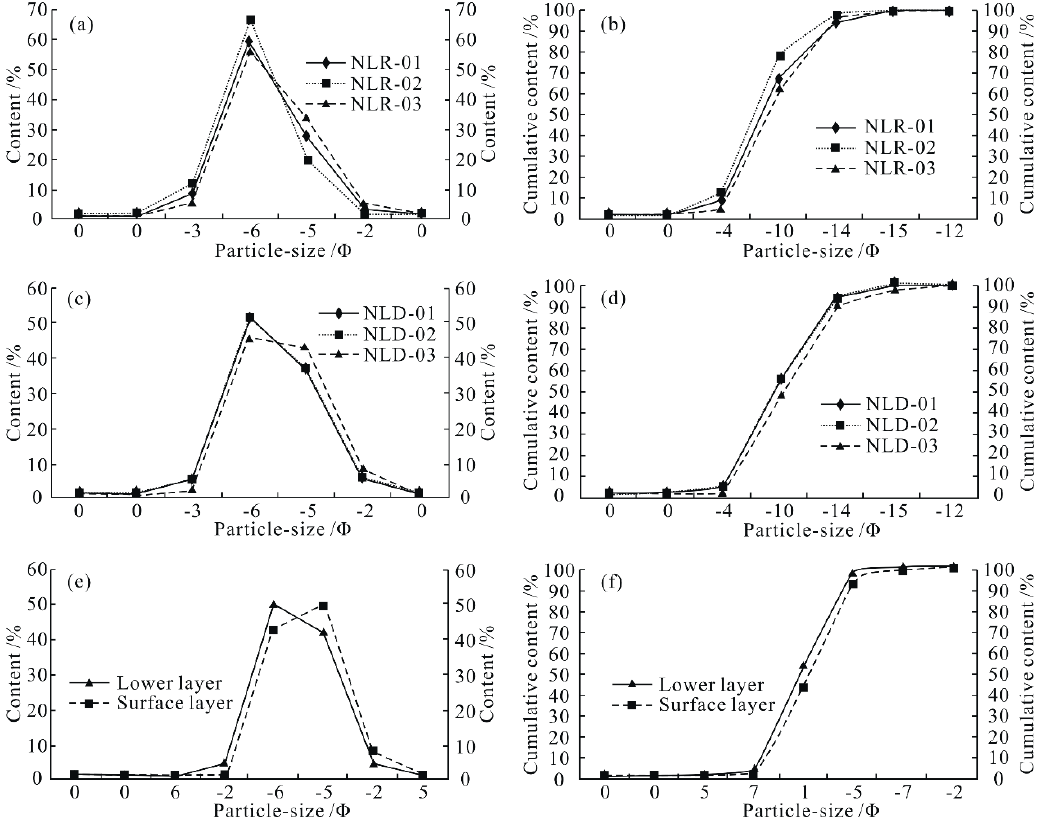
Figure 8. Particle-size frequency distribution and cumulative frequency distribution curves of samples from multi-stage fans and aeolian sand. ( a ), ( b ) Fine-grained samples from a multi-stage fan in eastern Nuoertu Lake. ( c ), Coarse-grained samples from a multi-stage fan in eastern Nuoertu Lake. ( e ), ( f ) Aeolian sand samples from eastern Nuoertu Lake. ( Ф is de fi ned as = − log2d. d is particle diameter (mm)).